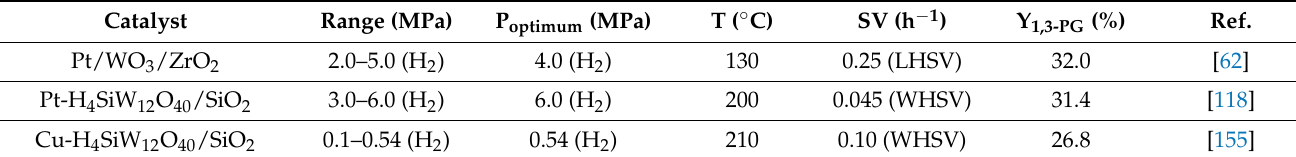
Table 12. The effect of pressure in continuous flow reactors using different catalysts.